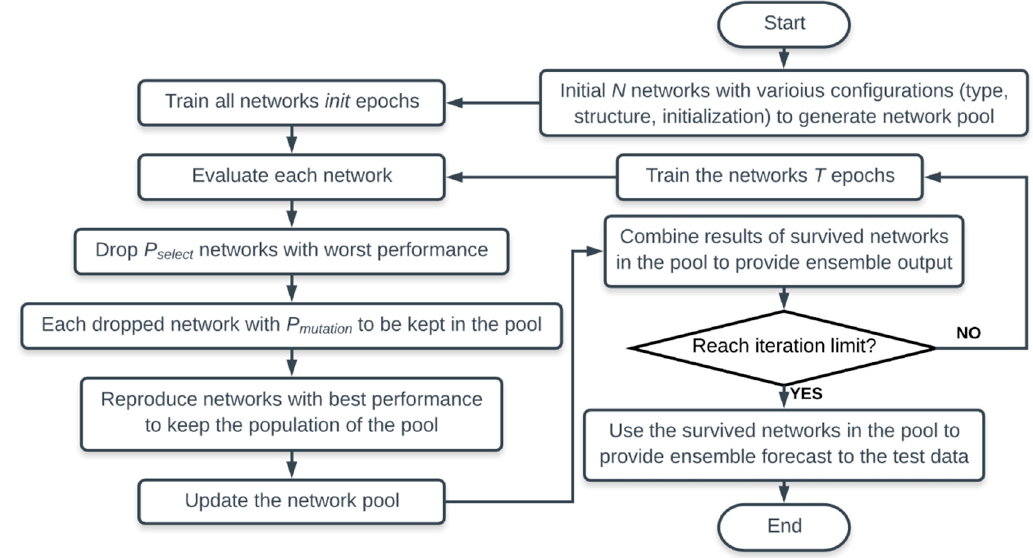
Figure 3. Workflow of the evolutionary ensemble method.